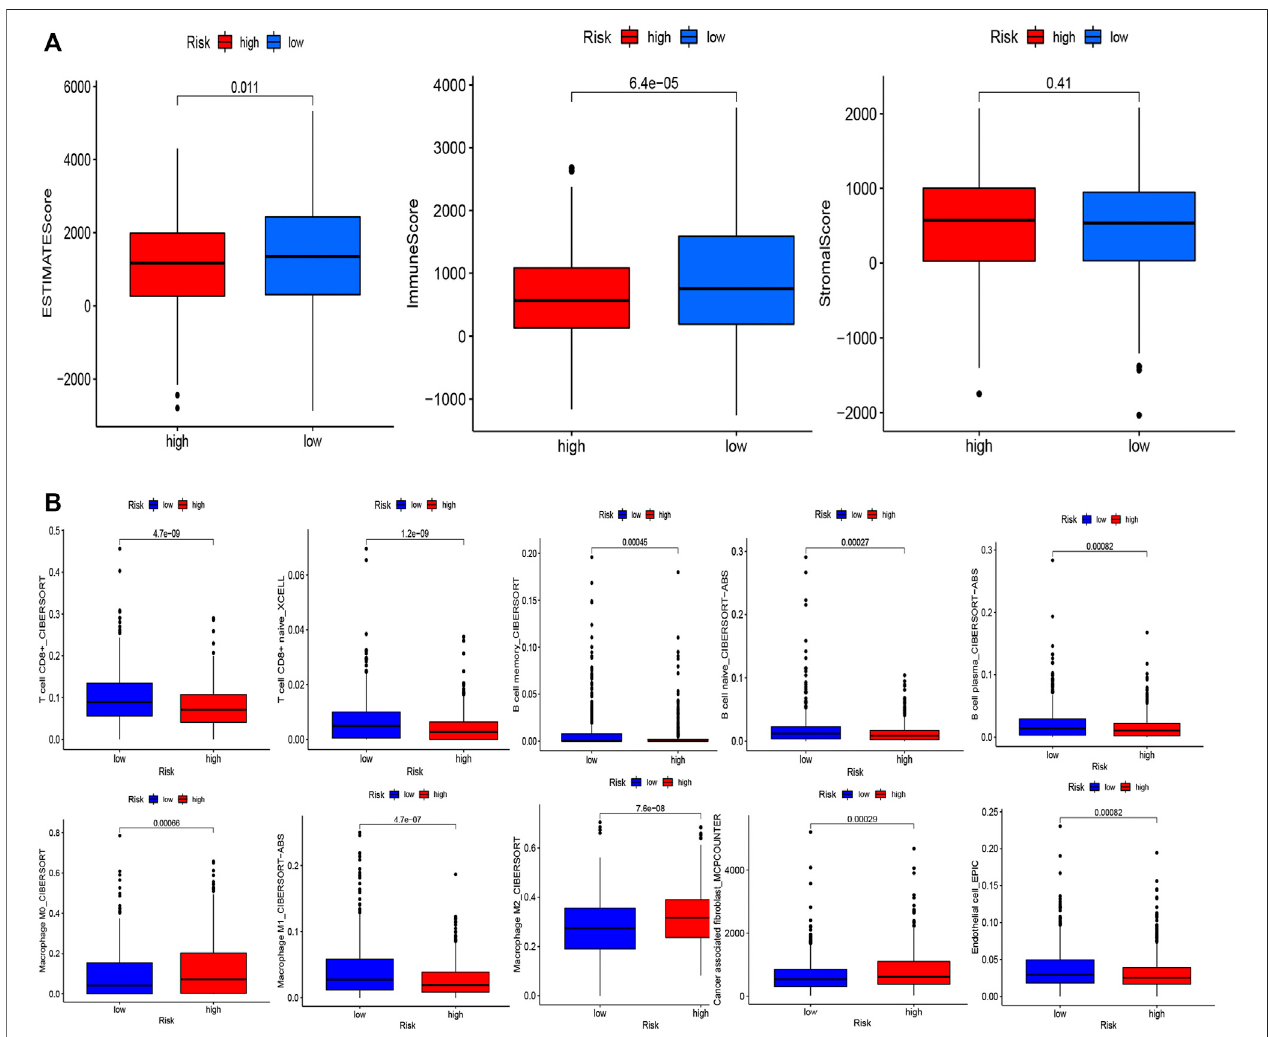
FIGURE 7 | Evaluation of the TME and levels of lymphocyte in fi ltration in the two groups. (A) Associations between the risk score and the immune and stromal scores. (B) Associations between the risk score and immune cell types.